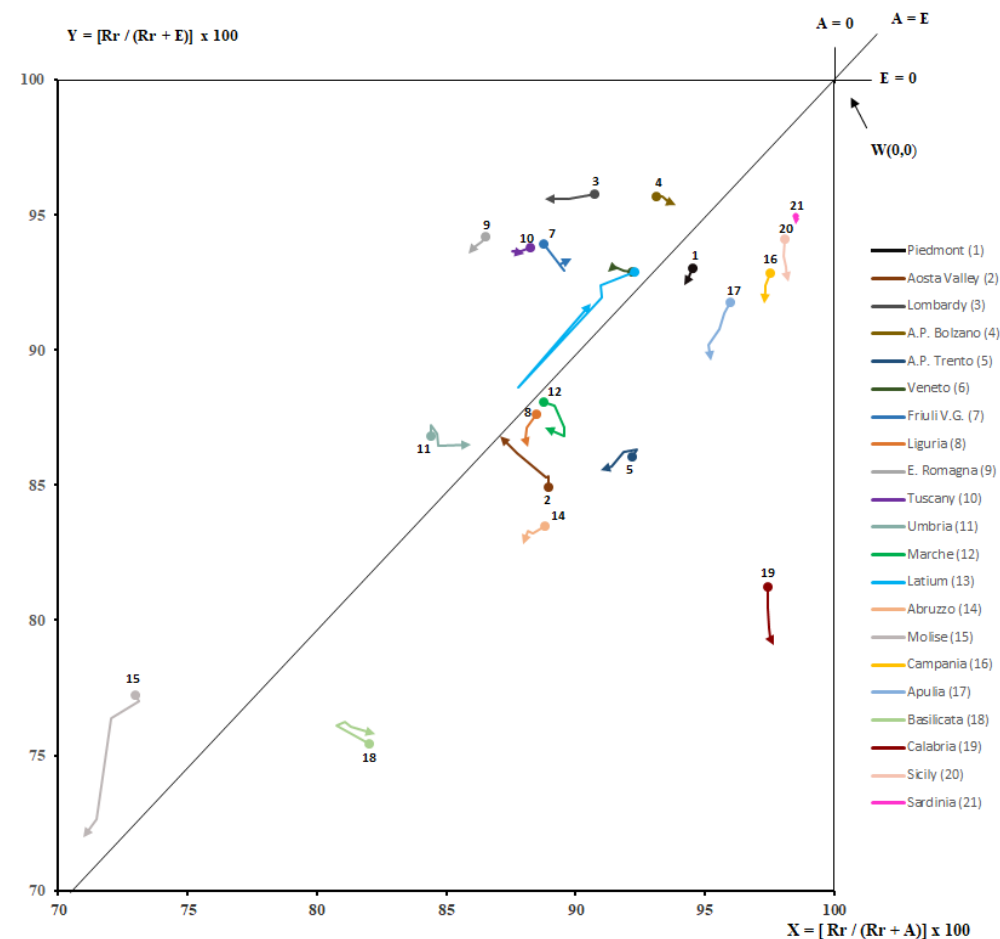
Figure 7. Gandy’s Nomogram of patients’ hospital mobility (upper right quadrant, from 2013 to Figure 7. Gandy's Nomogram of patients’ hospital mobility (upper right quadrant, from 2013 to 2017).